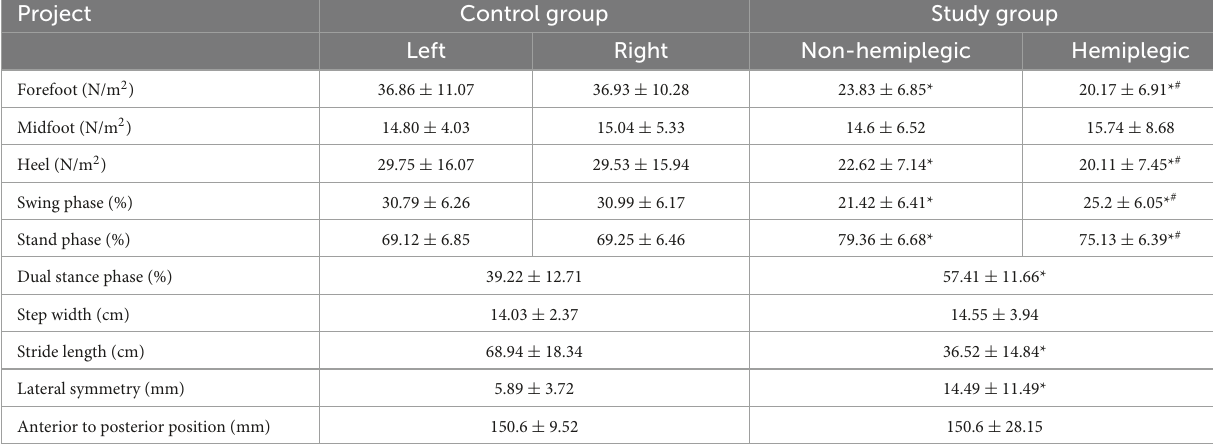
TABLE 2 Comparison of peak plantar pressure and gait parameters in both groups.